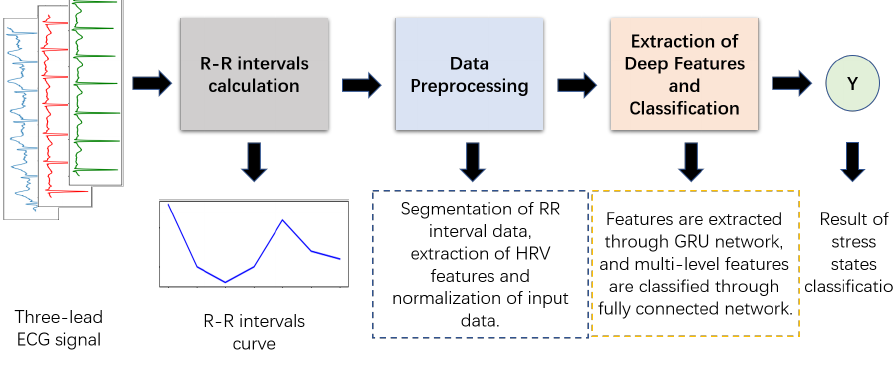
Figure 4. The overall process of the deep classification method based on the GRU network proposed in this